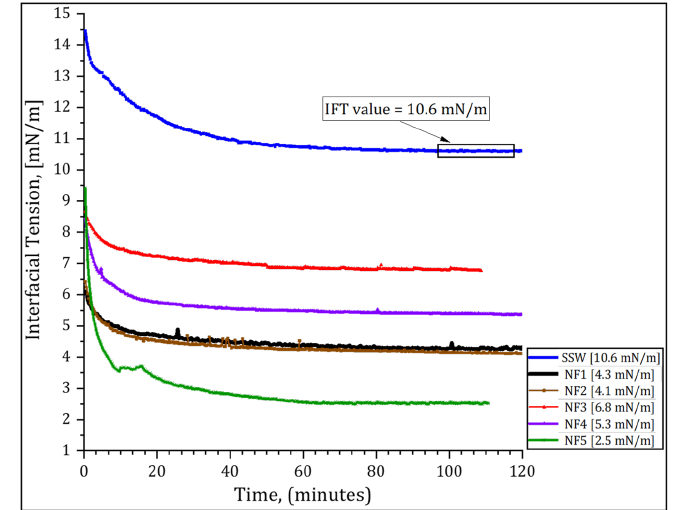
Figure 6. Interfacial tension values between crude oil and aqueous solutions of polymer-coated silica